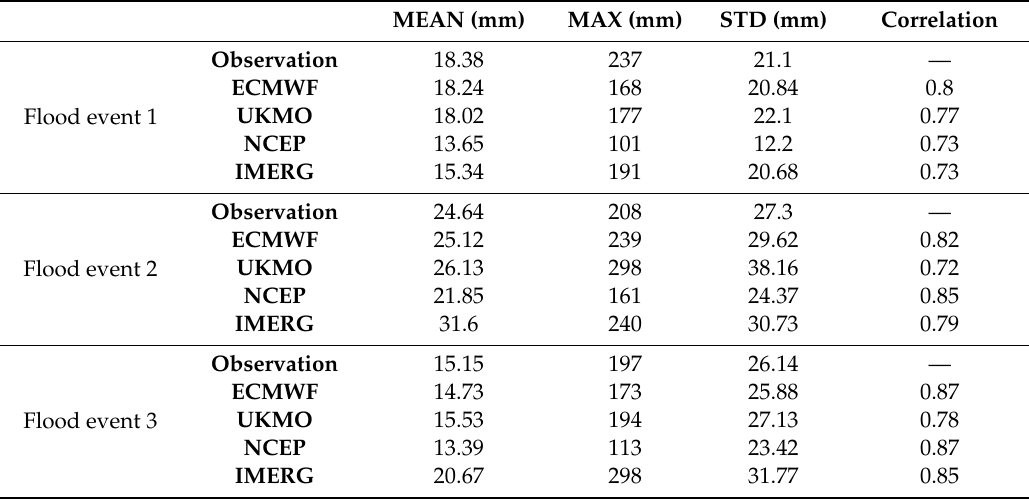
Table 3. Statistical characteristics of the observations, NWP, and IMERG satellite precipitation data.